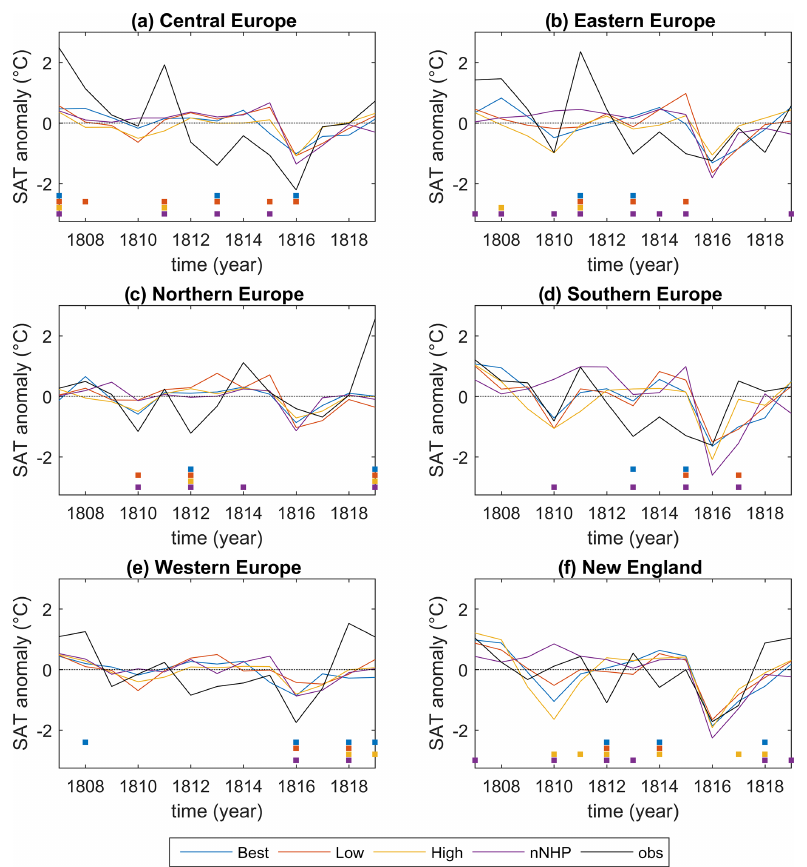
Figure 12. Seasonal mean near-surface NH summer temperature anomalies ( ◦ C) with station data averaged over different regions: (a) central Europe (46.1–52.5 ◦ N, 6–17.8 ◦ E), (b) eastern Europe (47–57 ◦ N, 18–32 ◦ E), (c) northern Europe (55–66 ◦ N, 10–31 ◦ E), (d) southern Europe (38–46 ◦ N, 7–13.5 ◦ E), (e) western Europe (48.5–56 ◦ N, 6 ◦ W–6 ◦ E), and (f) New England (41–44 ◦ N, 73–69 ◦ W). The black line represents measurements, and the colored lines represent the ensemble mean of the model simulations. The squares on the bottom of each panel indicate years when the measurement lies outside the simulation ensemble range (color code as for the ensemble mean). Anomalies are taken with respect to the years